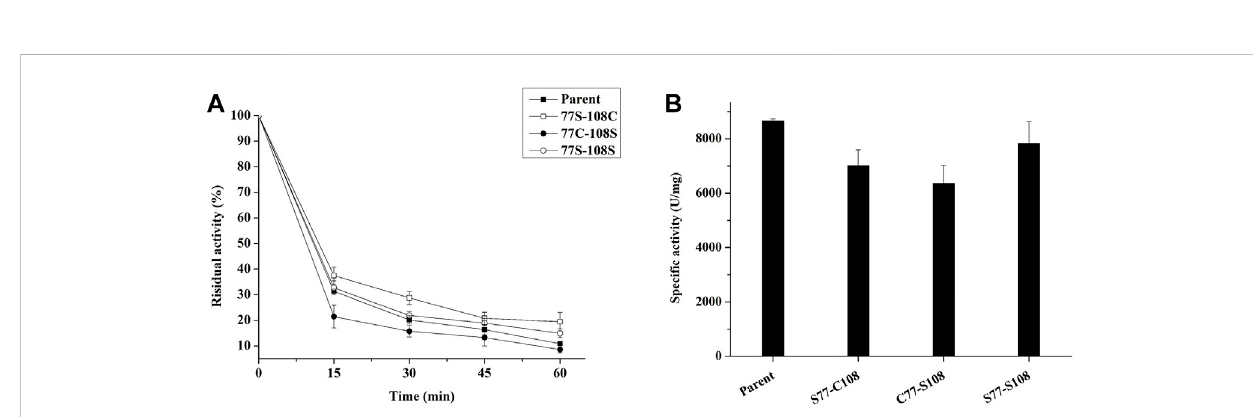
FIGURE 7 Effect of C77-C108C disul fi de bonds on the thermal stability of phytase. (A) The thermostability of mutants with each pair of cysteine residues involved in disul fi de bond formation mutated to serine (incubating at 99 ° C for different times); (B) The speci fi c enzyme activity of mutants with each pair of cysteine residues involved in disul fi de bond formation mutated to